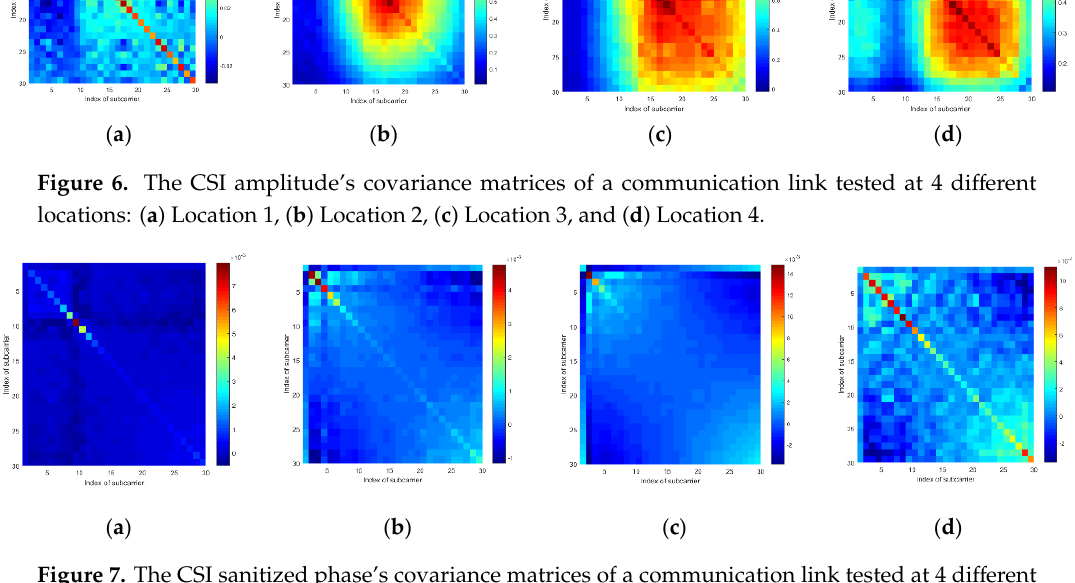
Figure 7. The CSI sanitized phase’s covariance matrices of a communication link tested at 4 different locations: ( a ) Location 1, ( b ) Location 2, ( c ) Location 3, and ( d ) Location 4.